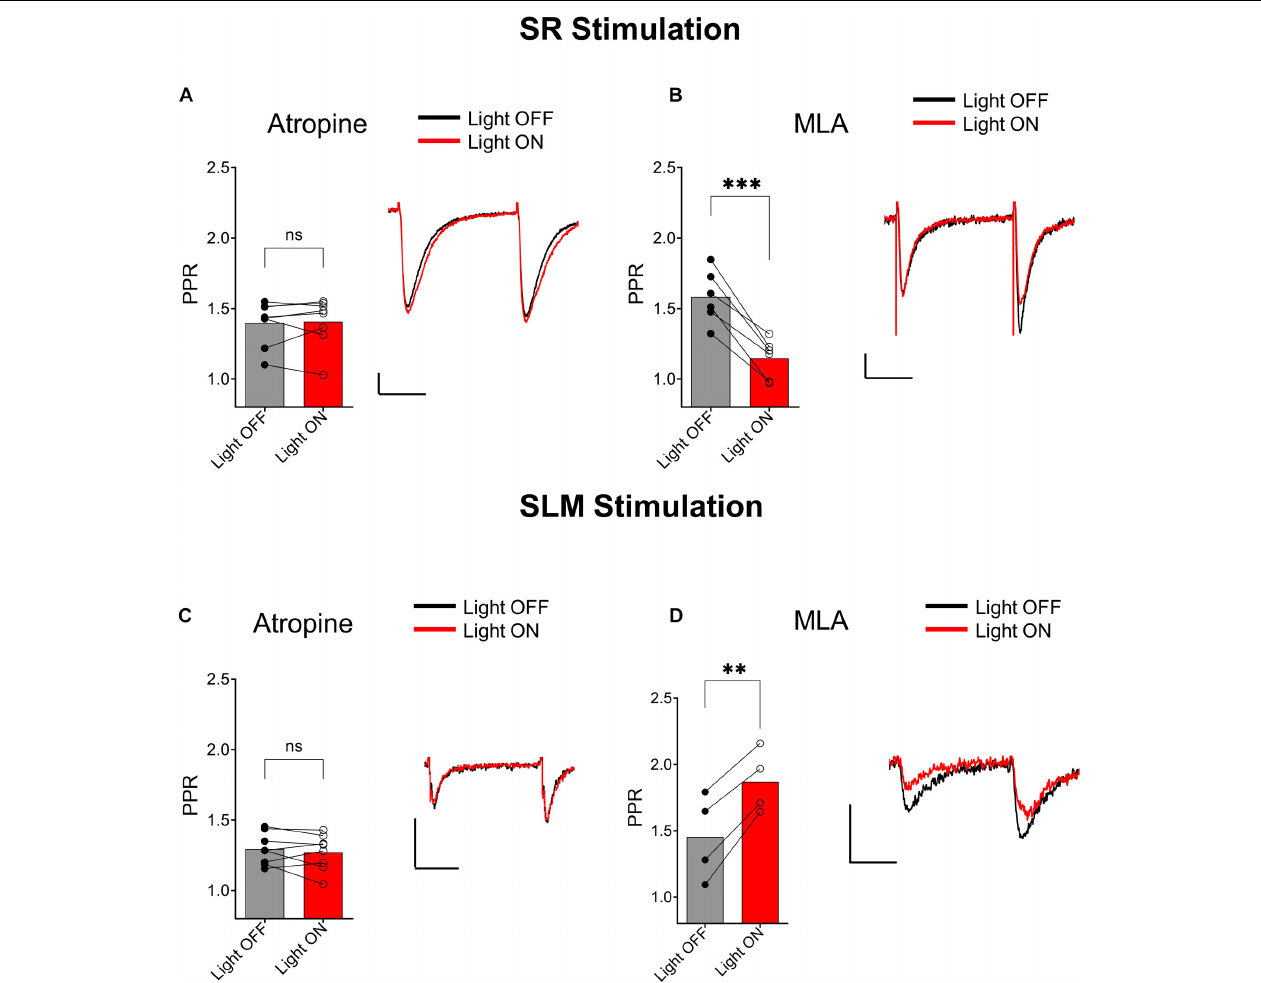
FIGURE 4 | Muscarinic receptor activation mediated synaptic inhibition by ACh release in both the SC and TA pathways. (A) Bar plot of SC PPR (left) and representative EPSCs (right) demonstrates that atropine prevented ACh (red) mediated suppression of SC synaptic amplitudes and PPR (paired t -test; p = 0.7629). (B) Bar plot of SC PPR (left) and representative EPSCs show MLA had no effect on ACh (red) mediated inhibition of SC EPSCs and PPR (paired t -test; p = 0.0007). Scale bars: x = 20 ms; y = 50 pA. (C) Bar plot of SLM PPR (left) and representative EPSCs (right) show atropine blocked both the ACh (red) mediated inhibition of SLM EPSC amplitudes and increase in SLM PPR (paired t -test; p = 0.7159). (D) Bar plot of SLM PPR (left) and representative EPSCs (right) show MLA did not prevent the effect of ACh release on SLM EPSC amplitudes or SLM PPR (paired t -test; p = 0.0036). Scale bars: x = 20 ms; y = 50 pA.